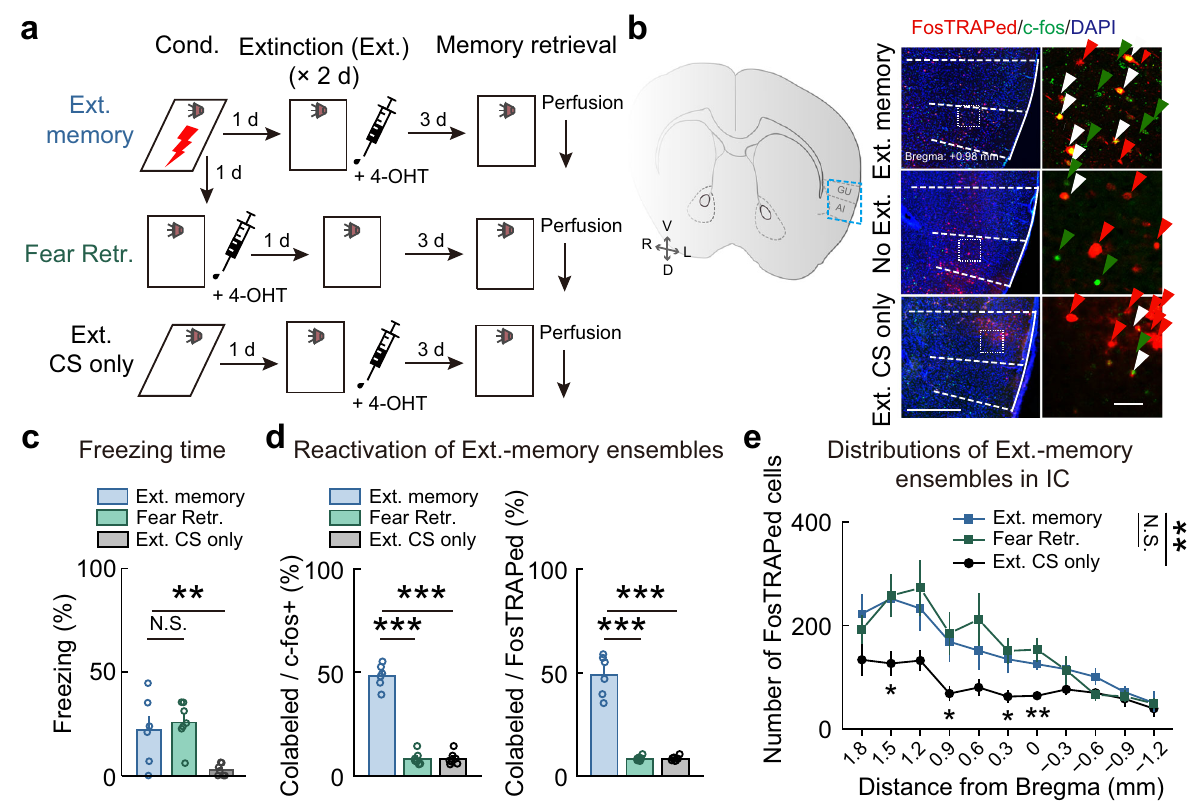
Fig. 2 | FosTRAPed extinction-memory ensembles in IC. Similar to Fig. 1, for activated IC neurons during extinction training and memory retrieval. Extinction (Ext.) memory, n =6 mice; fear retrieval without extinction (Fear Retr.), n =7 mice; Ext. CS only, n =7 mice. a Schematic of behavioral protocols. b Example images of FosTRAPed (red) and c-fos+ (green) neurons in IC.Scale bars, ( left ) 500 μ m, ( right ) 50 μ m. c Freezing responses to the CS. F (2, 17) =8.603, ** P =0.0026, one-way ANOVA,maineffectofgroup,followedbyStudent-Newman-Keulstest.N.S.forExt. memory vs. Fear Retr., ** P for Ext. memory vs. Ext. CS only. d Overlap rate of IC neurons activated during extinction training or fear-memory retrieval versus extinctionmemoryretrieval.Left, F (2,17) =176.3,*** P =4.2874E − 12,one-wayANOVA, followedbyStudent-Newman-Keulstest.*** P forExt.memoryvs.FearRetr.,*** P for Ext. memory vs. Ext. CS only. Right, F (2, 17) =95.35, *** P =5.7644E − 10, one-way